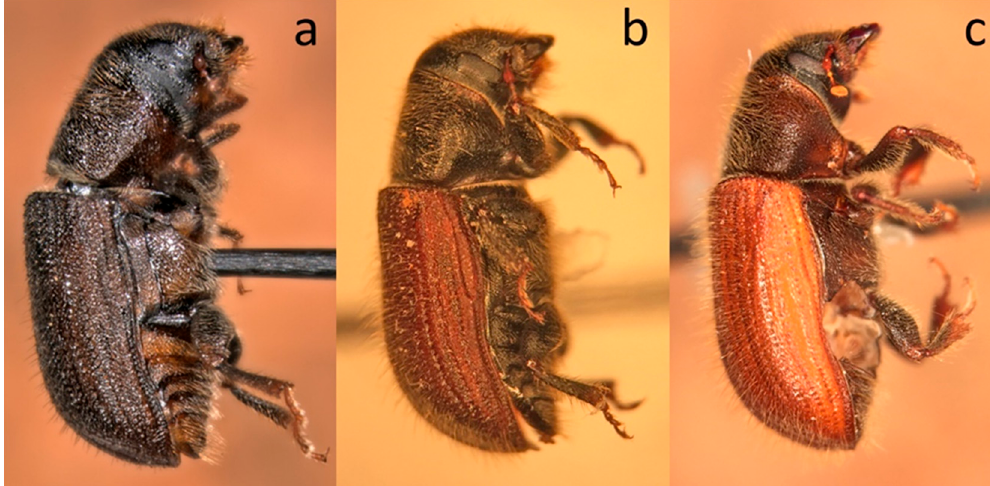
Figure 2. Three Dendroctonus bark beetles attacking P. contorta in the southern Rocky Mountains (SRM): ( a ) D. ponderosae distinguished from the other two by having equally colored thorax and elytra and shorter elytral declivity setae, ( b ) D. rufipennis examined in the SRM had duller exoskeletal surfaces than ( c ) D. murrayanae . Pictures by J. Mercado.